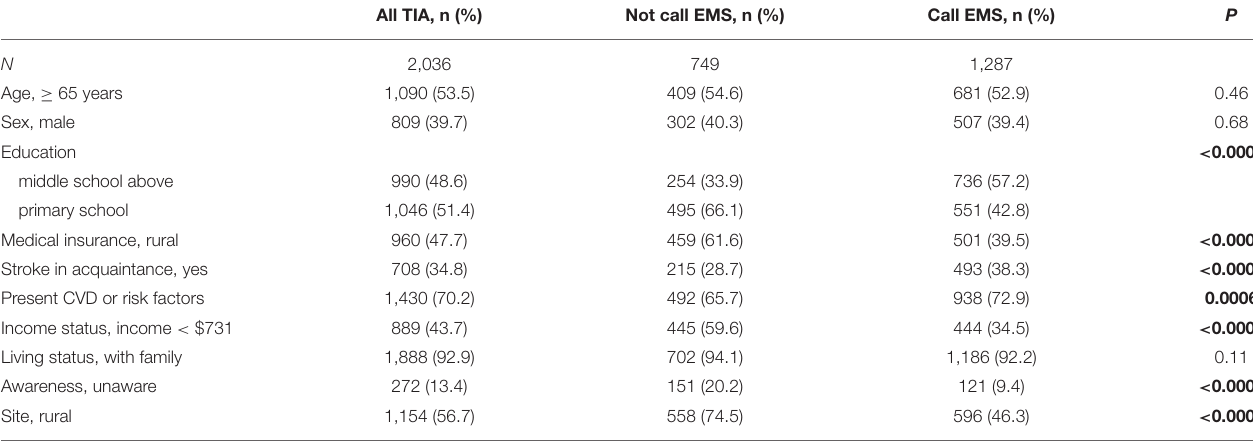
TABLE 1 | Characteristics of all participants with previous TIA history and by intention to call EMS. All TIA, n (%)